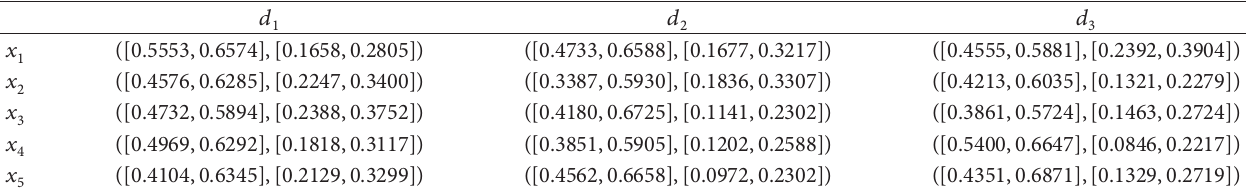
Table 6: Group decision matrix